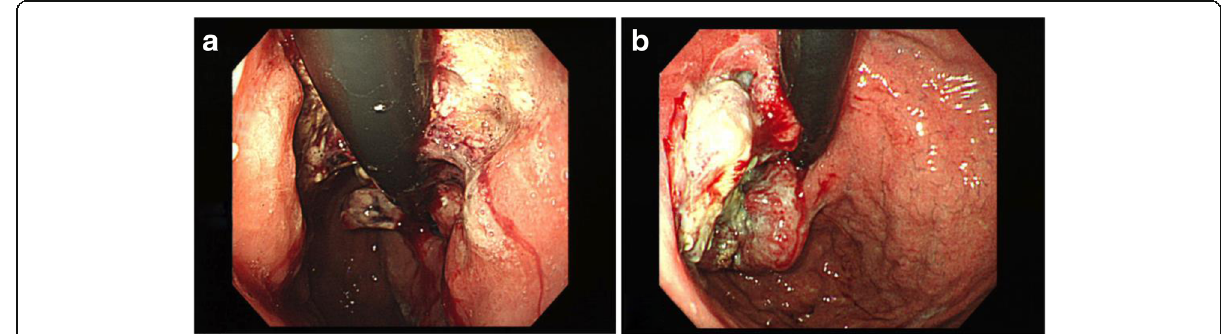
Fig. 2 Gastroenterological endoscopy findings. Gastroenterological endoscopy revealed tumor lesion with widespread ulceration in the gastric cardia, a in October 2009 and b in June 2011. The stomach lesion decreased after 2 years of chemo-immunotherapy, preoperatively